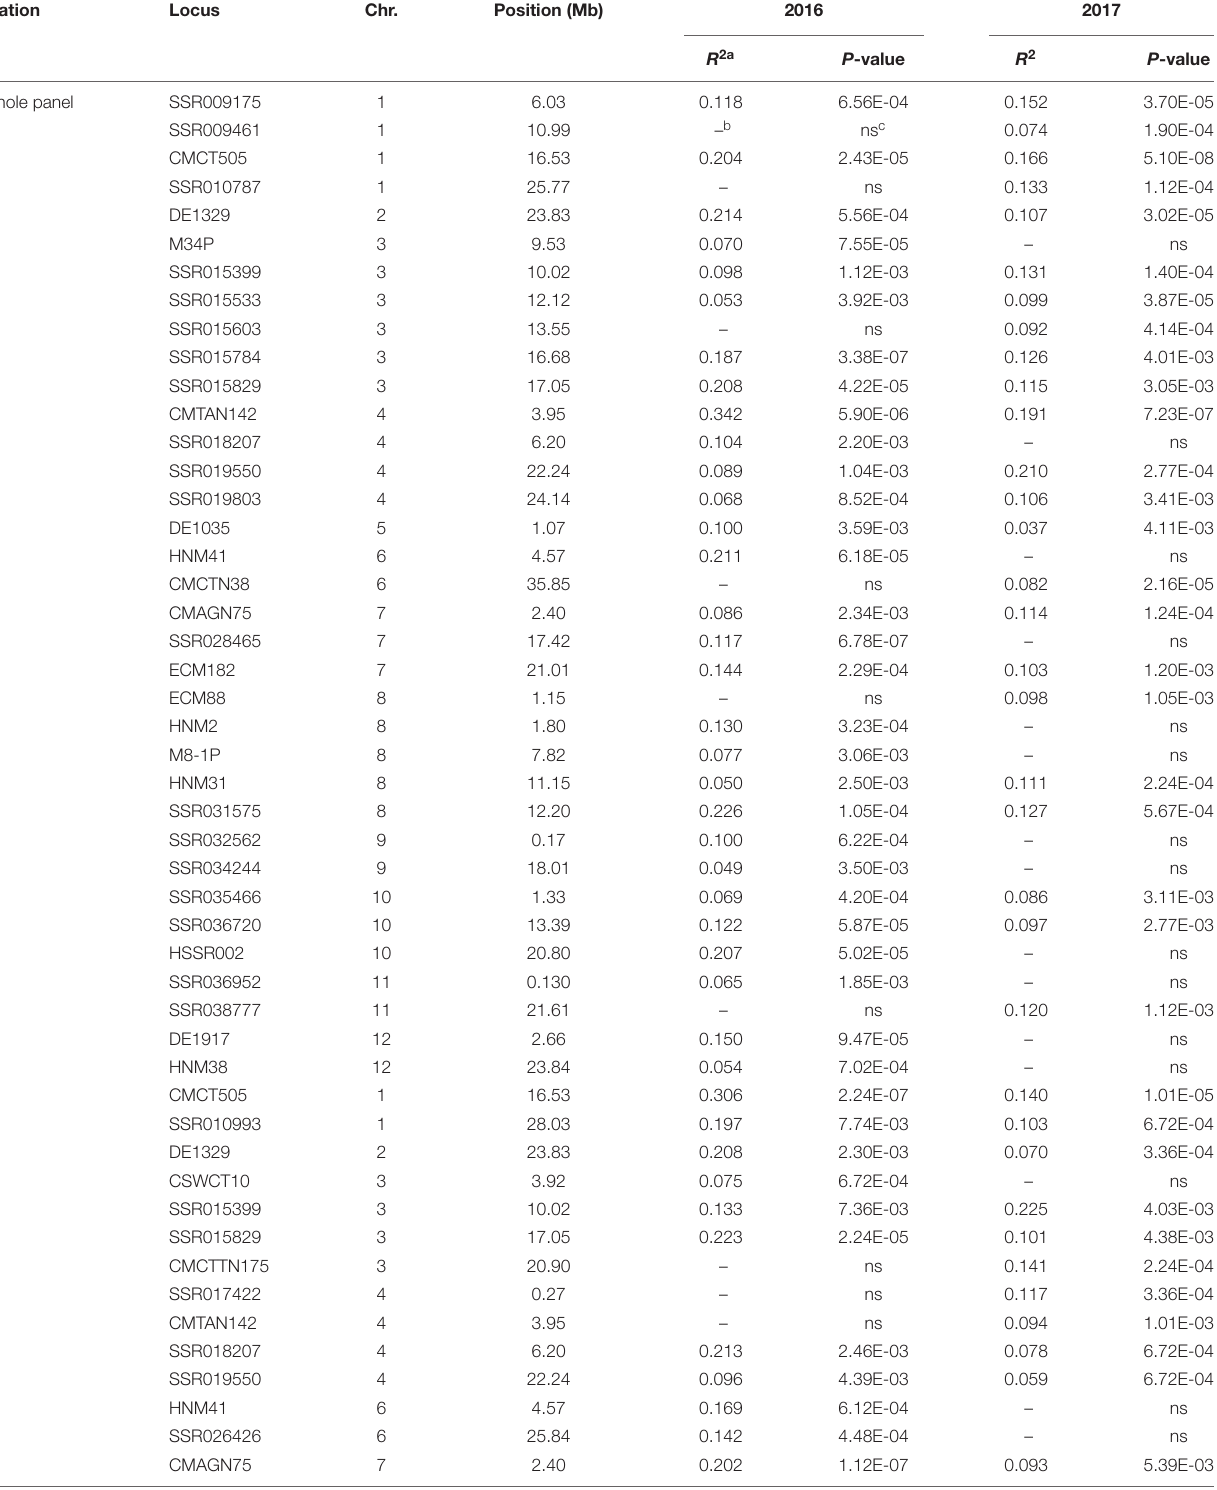
TABLE 2 | Summary of the marker loci significantly associated with CII values mapped in the whole panel and the two subgroups. Population Locus Chr.